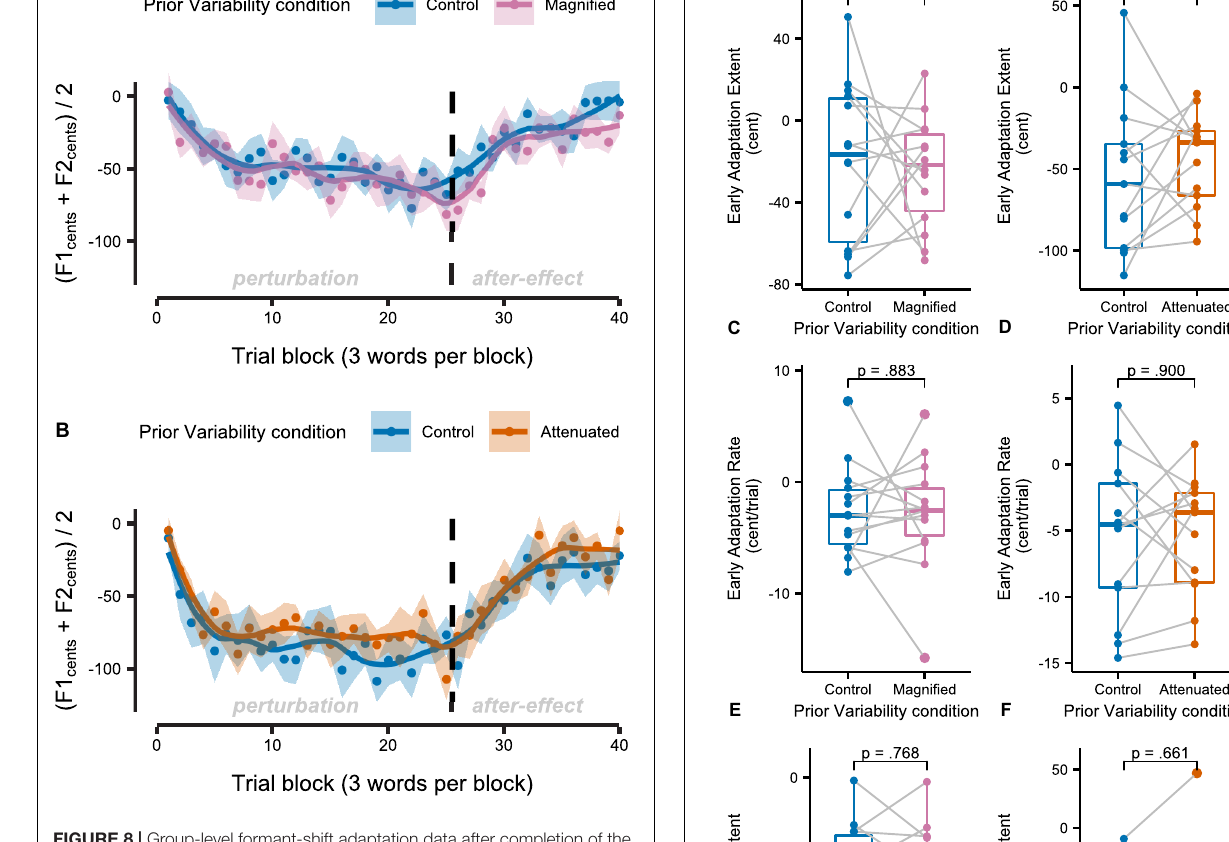
FIGURE 8 | Group-level formant-shift adaptation data after completion of the Variability task’s Control and Magnified conditions (A) or after the Control and Attenuated conditions (B) . Dots represent group mean formant frequencies per block (3 trials) and averaged across F1 and F2. Shaded regions indicate standard error of the mean. Solid lines are loess smoothed fits (span = 0.3).